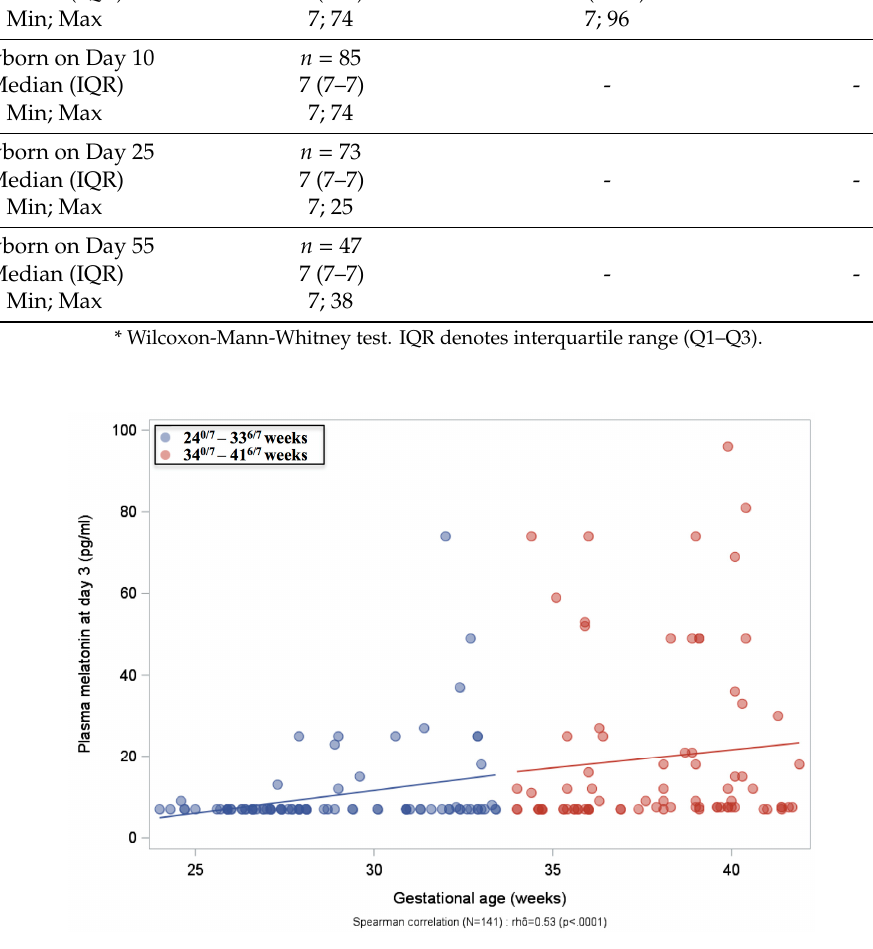
Figure 2. Spearman correlation between plasma melatonin concentration (pg/mL) and gestational age on Day 3.